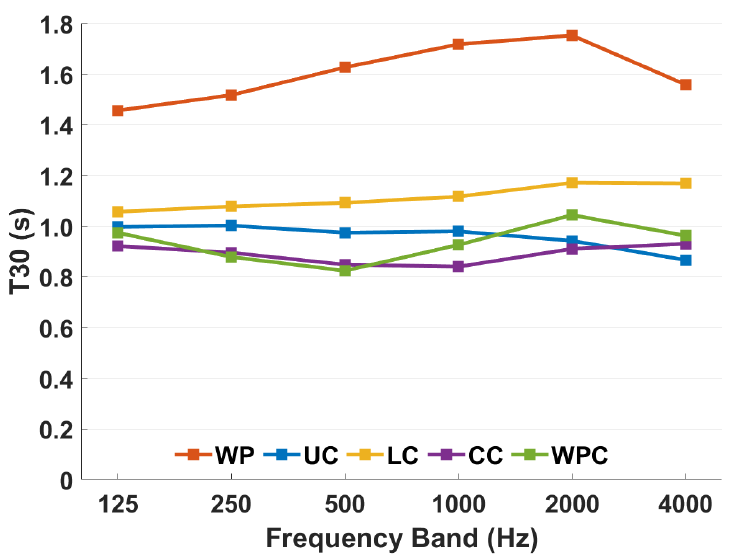
Figure 9. Average values of T30 obtained from experimental versions in ODEON by using different materials to define the surfaces of the seating